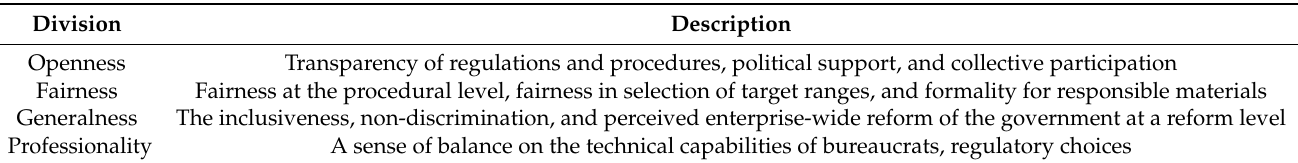
Table 3. Evaluation Framework for DIA